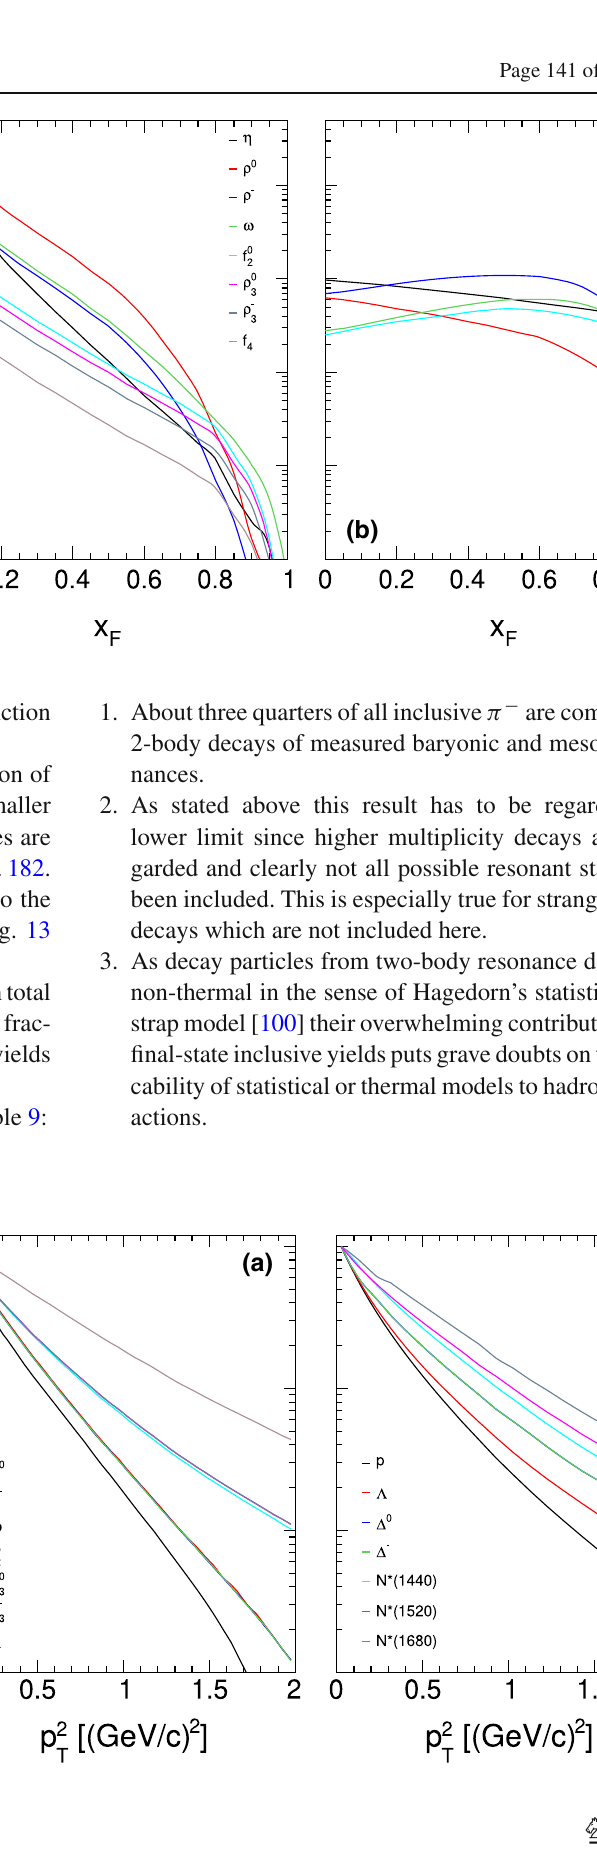
Fig. 182 Normalized dn / dp 2 distributions as a function of p